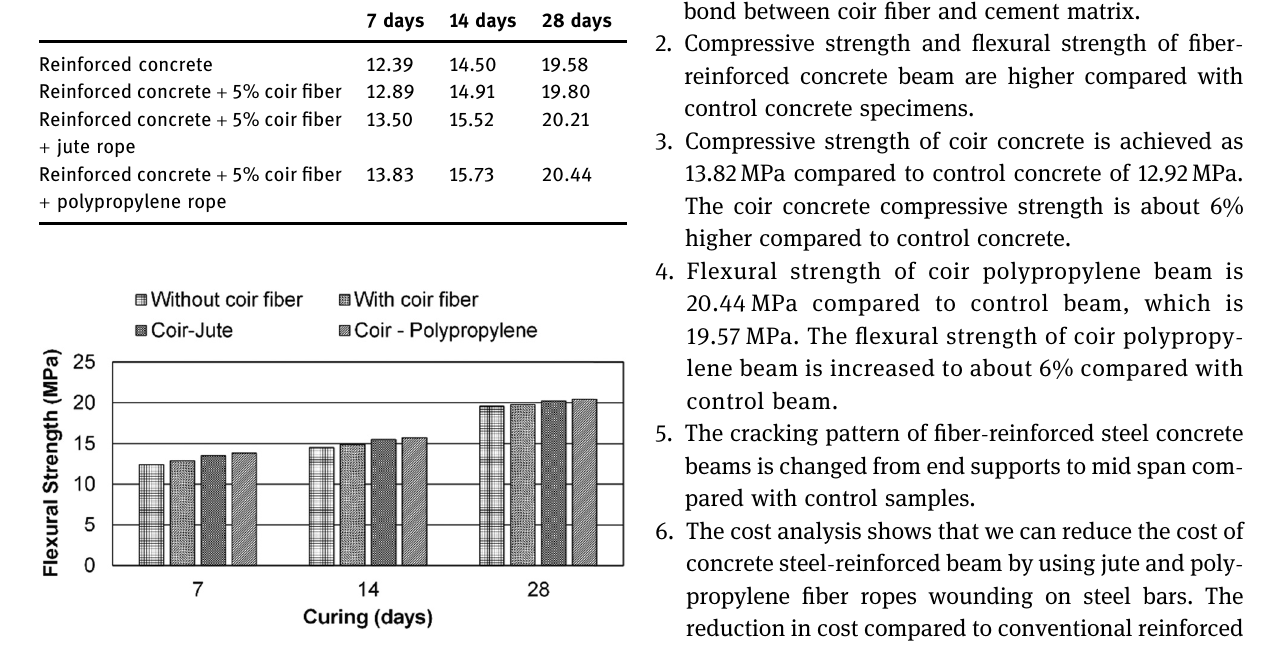
Table 7: Flexural test on beam specimens Specimen conditions